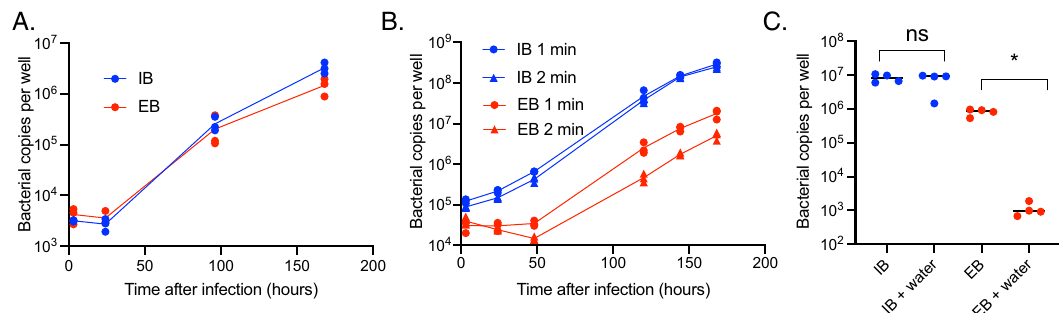
Fig. 5 Both IB and EB populations are infectious but differ in physical stability. IB and EB Ot were isolated from infected L929 cells 5 days post-infection and grown in fresh L929 cells in a 24-well plate. The number of intracellular bacteria was then quanti fi ed at 3-, 24-, 96-, and 168 h post-infection using qPCR against tsa47 , a single copy Ot gene. Doubling times of IB and EB Ot were similar. Similar results were found in HUVEC cells (Supplementary Fig. 8). B IB and EB were exposed to physical stress using a bead mill for 1 or 2 min; growth was quanti fi ed as in 4A. The bead mill did not affect the growth rate of IB Ot but reduced that of EB Ot in an exposure-dependent manner. C IB and EB were exposed to osmotic shock by suspending the bacteria in water for fi ve min and then growing them in fresh L929 cells. Bacterial copy number after 7 days was quanti fi ed by qPCR. EB was more susceptible to osmotic shock than IB Ot, as shown by a more signi fi cant decrease in bacterial number. Statistical signi fi cance was determined using a two-sided Mann – Whitney test. P = 0.0286. For ( A – C ) each datapoint was taken from a separate well from a 24-well